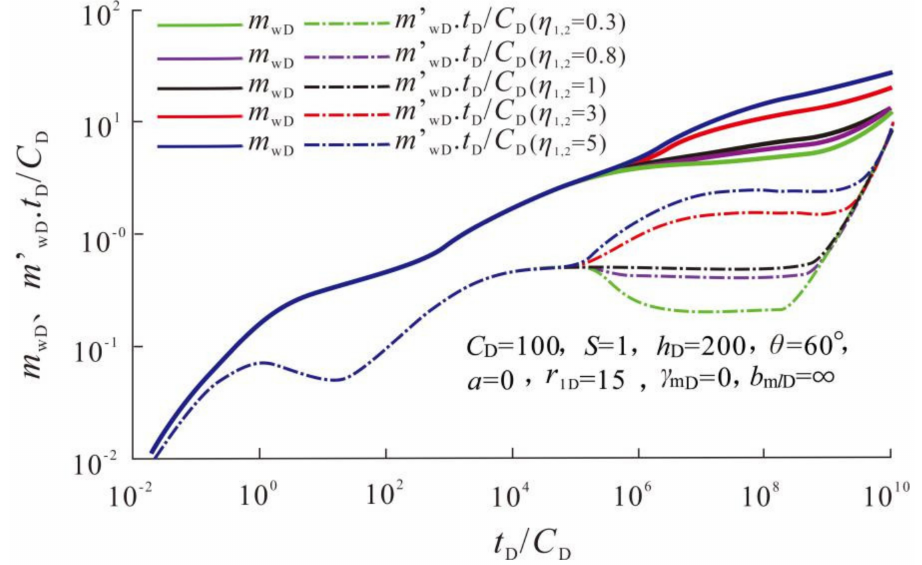
Figure 7. Effect of the pressure conduction coefficient ratio on dynamic pseudo-pressure